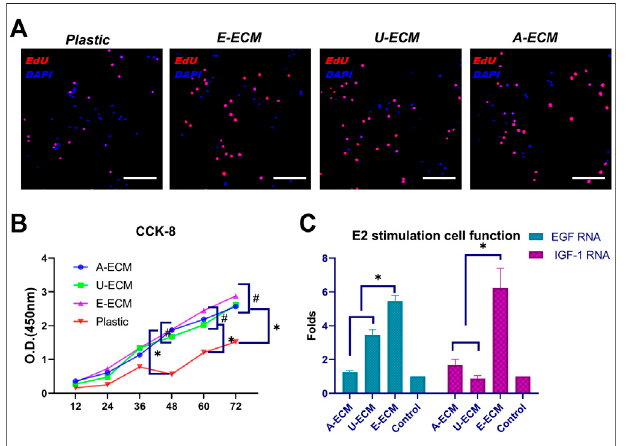
FIGURE 2 | Measurement of cell proliferation and secretion functions after culture with three different substrates. The cell proliferation and quantitation results for stromal cells cultured with different substrate coatings (A,B) and evaluation of the secretion functions of stromal cells (C) after oestrogen stimulation under the above conditions. * p < 0.05 and # p > 0.05, one-way ANOVA with Tukey ’ s post hoc test. Bar = 50 μ m.